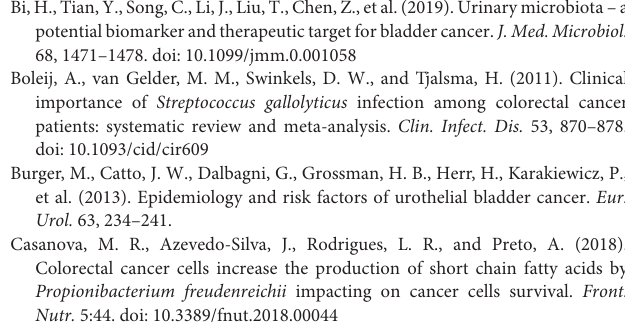
Supplementary Figure 1 | Jaccard and Bray–Curtis indices at the phylum (A) and genus (B) level. Non-metric multidimensional scaling (NMDS) plot based on Jaccard (frequency) and Bray–Curtis (abundance) indices show no differences between non-tumor mucosa (blue, n = 26) and tumor mucosa (yellow, n = 26) from bladder cancer patients with paired samples. Supplementary Figure 2 | Principal component analysis (PCA) of bacteria according to tumor grade at the genus level. PCA shows the microbial community composition of tumor tissues in relation to high grade (red cicles, n = 29) and low grade (blue triangles, n = 3). Principal component (PC1 and PC2) together, account for 39.6% of the variance in these data. Supplementary Figure 3 | Survival analysis estimates of the different clusters detected in tumor tissues. Kaplan-Meier survival analysis of bladder cancer patients according to Cluster 1 in red (significantly enriched for the genera Barnesiella, Parabacteroides, Prevotella, Alistipes, and Lachnospiracea_incertae_sedis ), Cluster 2 in blue (significantly enriched for the genera Staphylococcus ) and Cluster 3 in green (no significantly enriched) shows a better survival for patients in Cluster 2 with no statistically significant differences ( P =